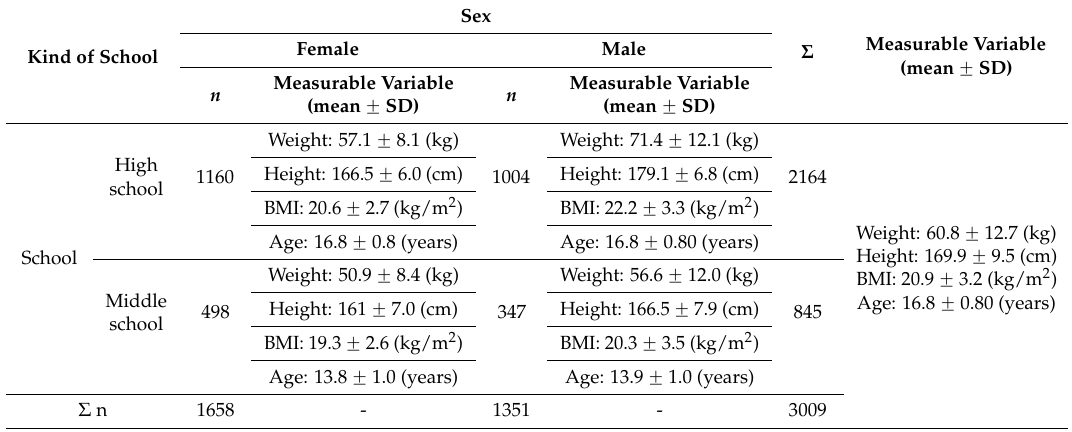
Table 1. Age and anthropometric data for adolescents enrolled in the study ( n = 3009).